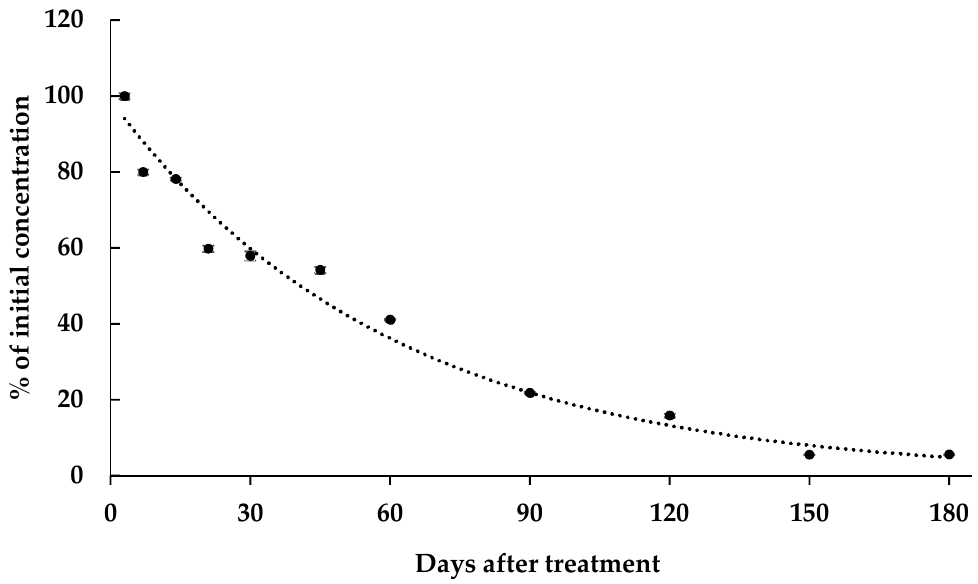
Figure 2. Dissipation of imicyafos in soil under greenhouse conditions. Data are means ± standard deviation (SD) of triplicate.